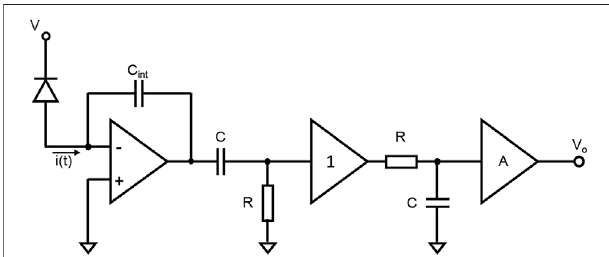
FIGURE 1 | Typical setup for X-rays spectroscopy. The photo- generated current is integrated and the resulting signal is shaped by a CR-RC fi lter. A single photon generates a voltage pulse whose amplitude is proportional to the photon energy.